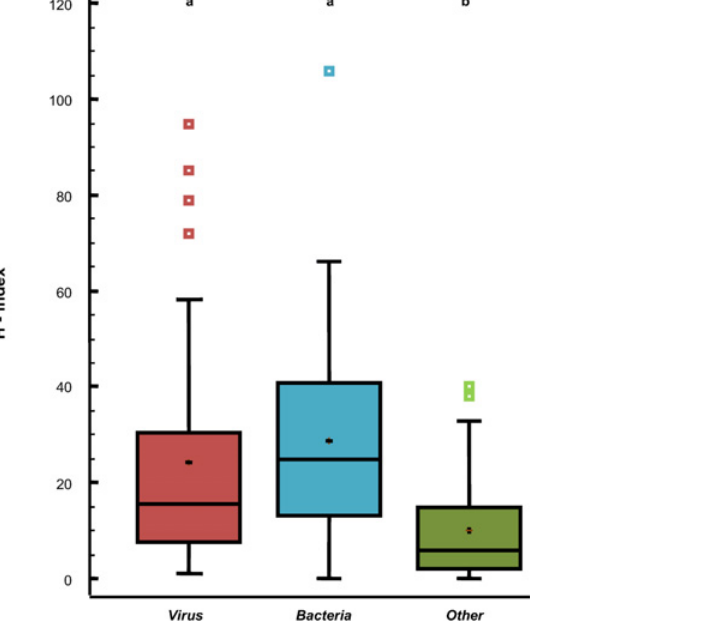
Fig 2. Box plot showing H-index score quartiles by taxonomic division. + Mean. a > b ( P < 0.001).